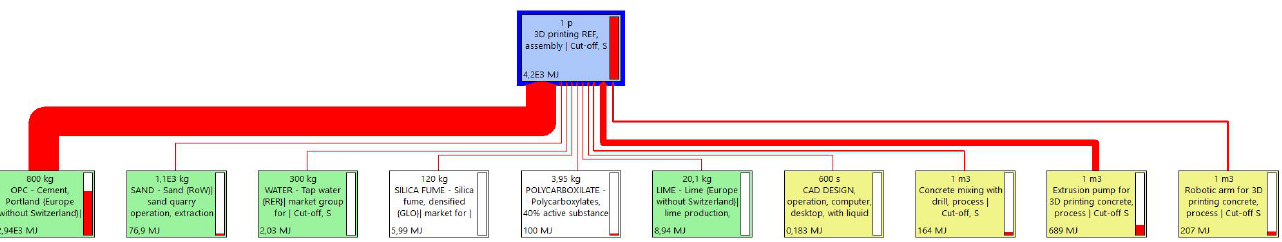
Figure A5. SimaPro CED network for p-CTR mix processing.